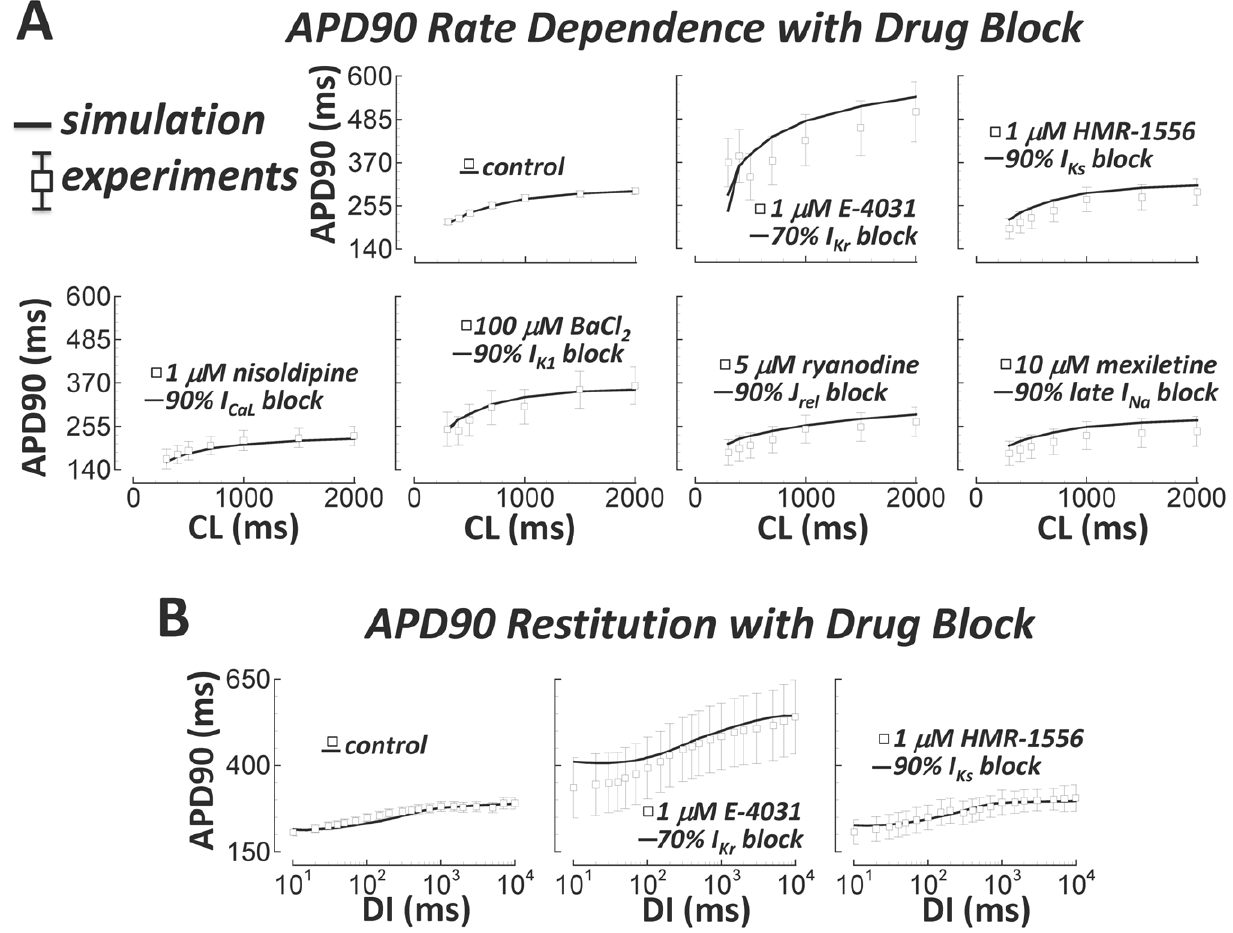
Figure 8. Pacing protocols with block of various currents. Experimental data (small tissue preparations) are white squares. A) Steady state APD90 rate dependence. From left to right, top to bottom: N=140, 5, 5, 5, 5, 4, and 4 hearts. Shown are control, I Kr , I Ks , I CaL , I K1 , RyR, and late I Na block. B) APD90 restitution (S1=1000 ms). From left to right: N=50, 3, and 4 hearts. Shown are control, I Kr , and I Ks block.